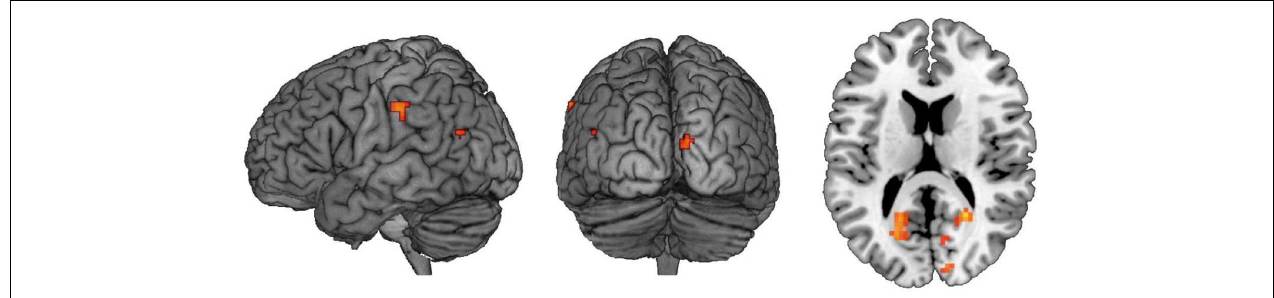
FIGURE 5 | Regions which show a no-think-couple/think-decouple relationship with left posterior hippocampus. Results of a whole-brain PPI analysis using a 4 mm sphere centered on MNI coordinates [ − 21, − 28, − 8]. Regions highlighted couple with the seed region during the no-think condition and decouple during the think condition. Images are thresholded at p < 0.001 with clusters comprising a minimum of five contiguous